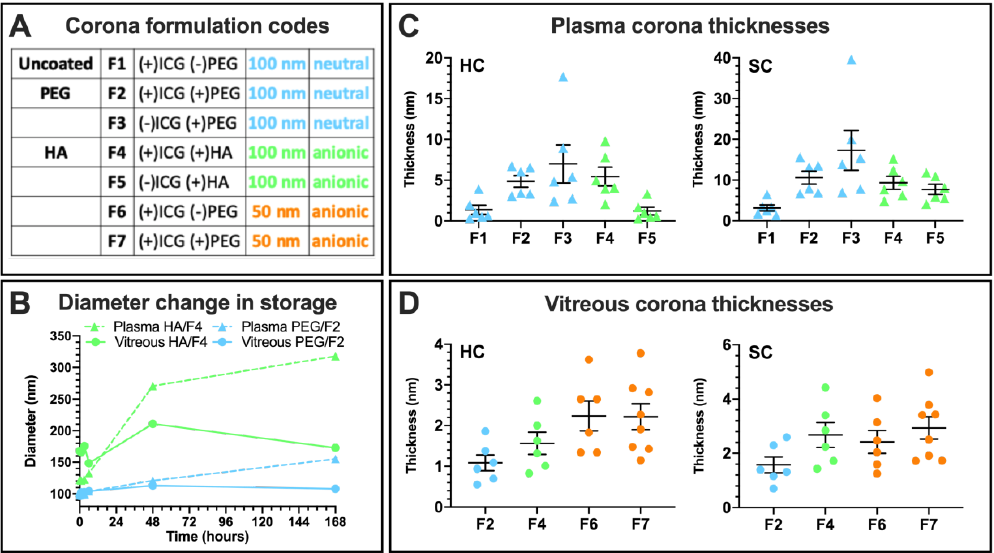
Figure 4. ( A ) Liposome formulations and their color-coded groups in corona experiments, combined with data from earlier studies [28,29]. ( B ) Large-angle light scattering measurements (LALS) for size change during storage in plasma and vitreous samples. ( C ) Surface plasmon resonance (SPR) measurements for hard (HC) and soft corona (SC) thickness in undiluted plasma with individual data points, mean, and SD. ( D ) Corona thicknesses in undiluted vitreous.